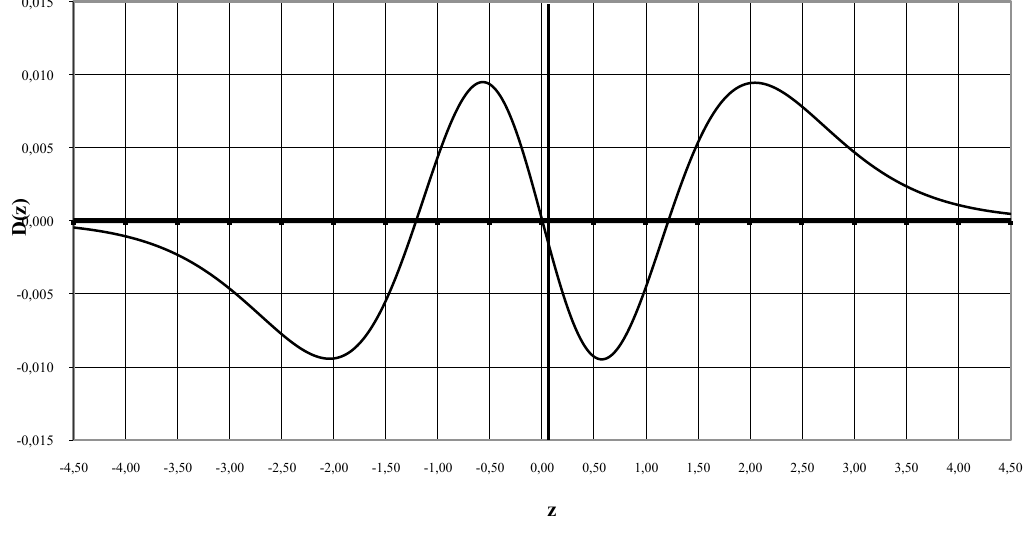
Figure 1. “The difference between the logistic function and cumulative normal distribution”.